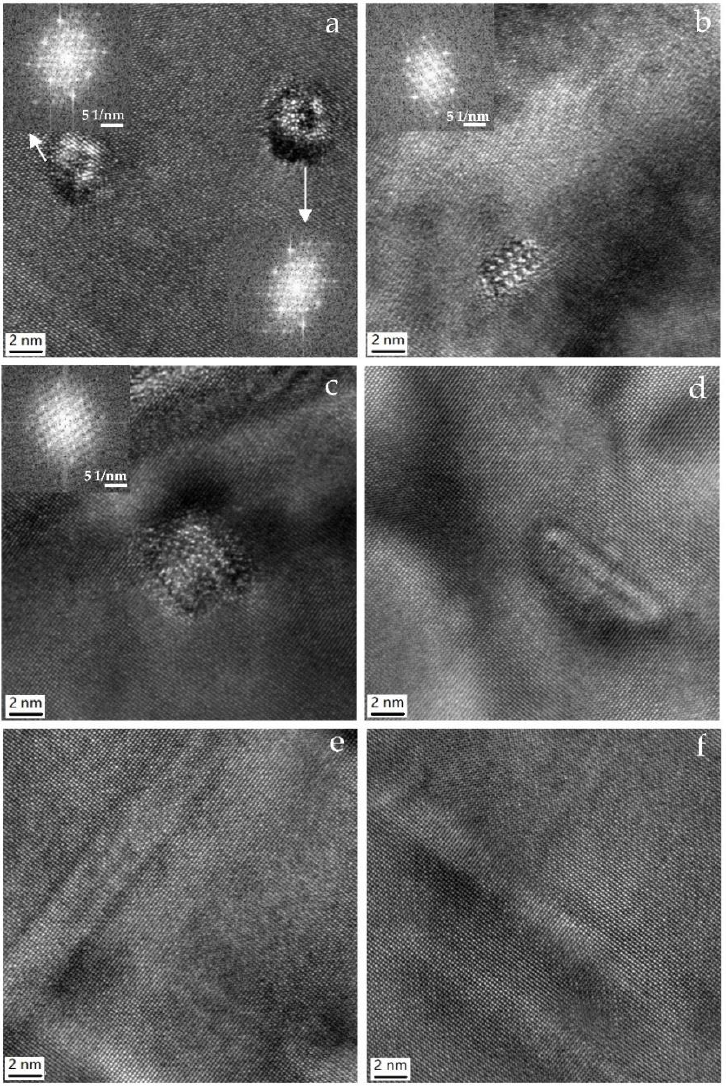
Figure 7. HRTEM images of the precipitates aged at 180 °C for 8 h and the fast Fourier transform of the HRTEM image. ( a – f ) HRTEM images of precipitates and the FFT of the HRTEM images.